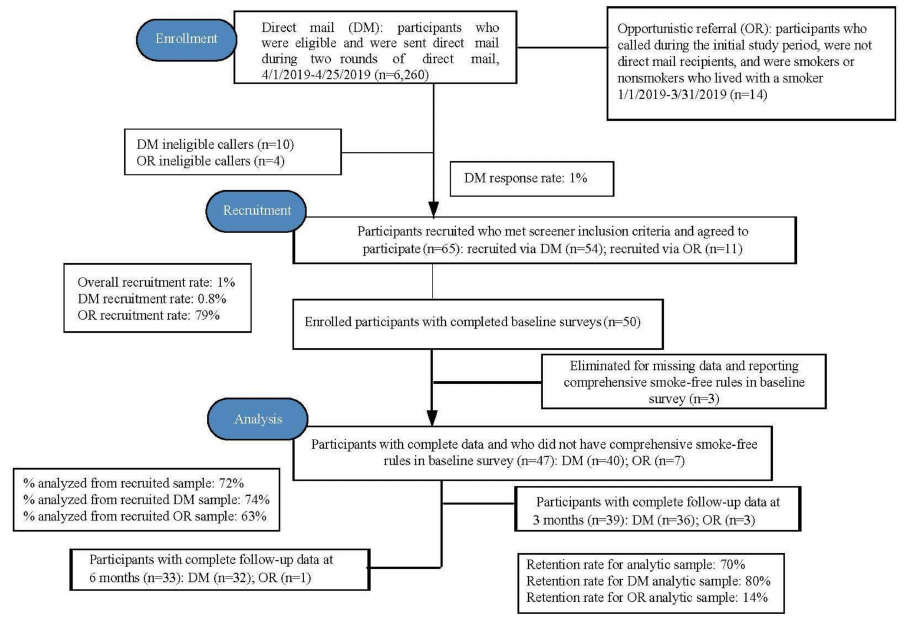
Figure 1. Participant flow